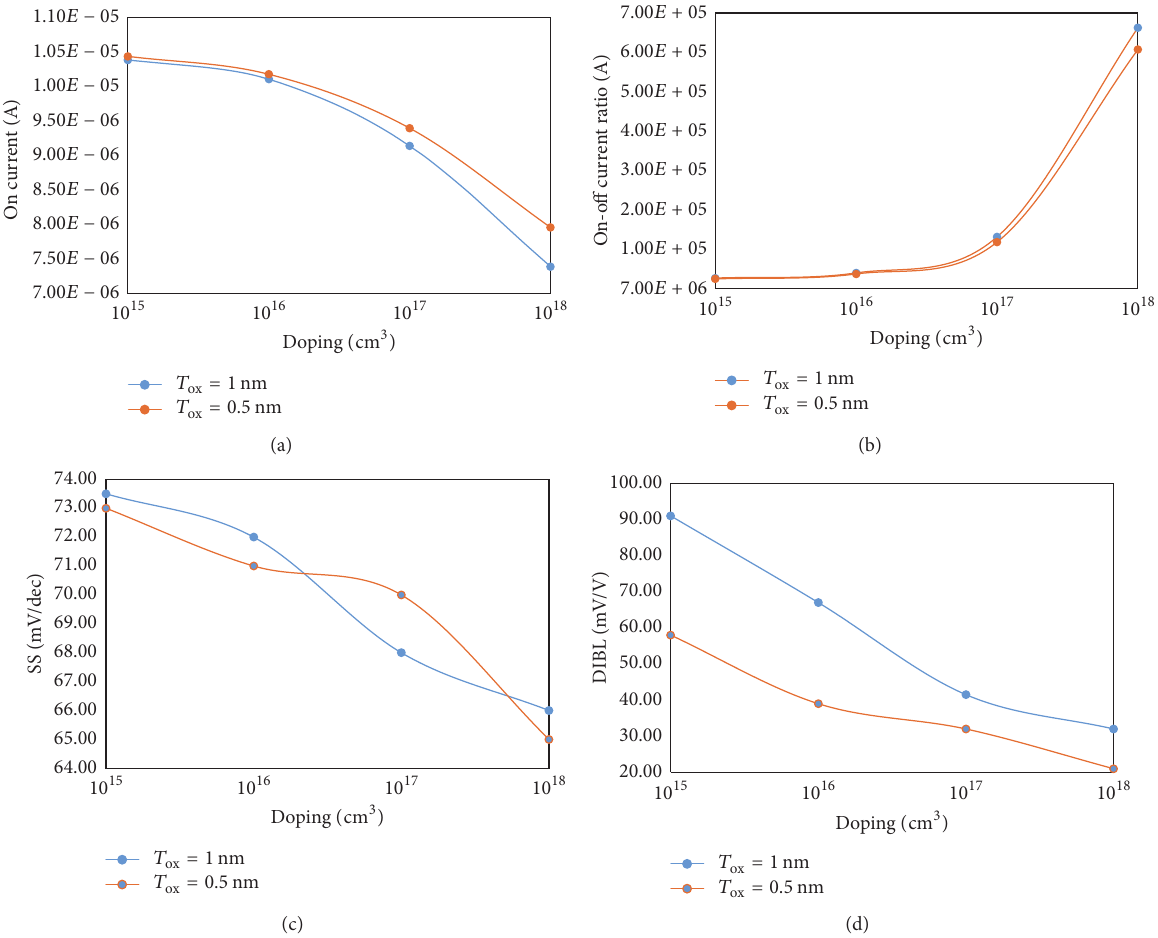
Figure 9: Variation of output parameters of FinFET with respect to different doping concentration for 𝑇 15nm. (a) On current. (b) On-off current ratio. (c) SS. (d)